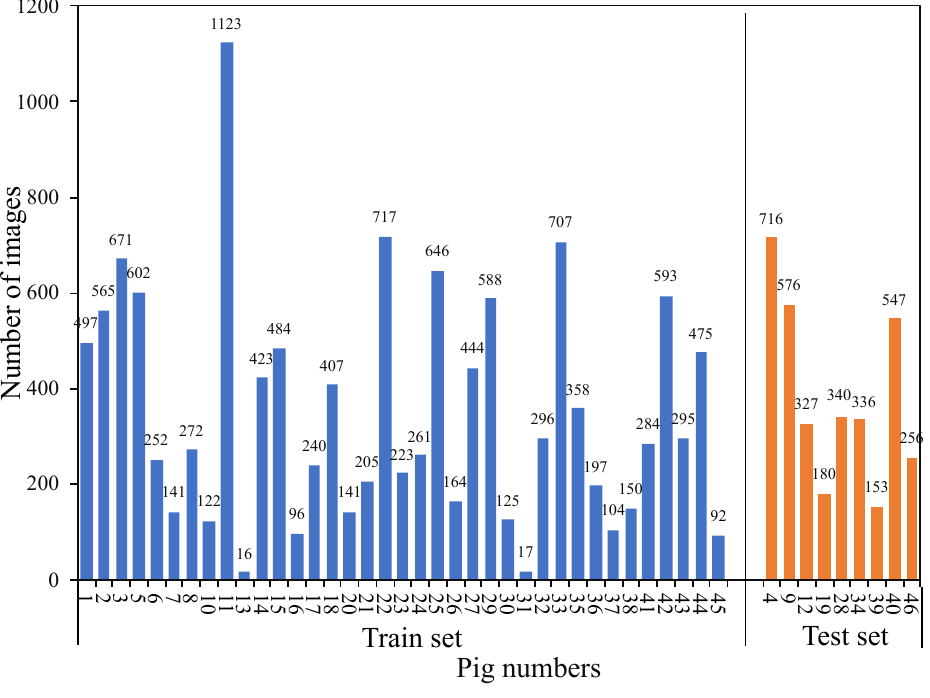
Figure 2. Image quantity distribution of the pig face